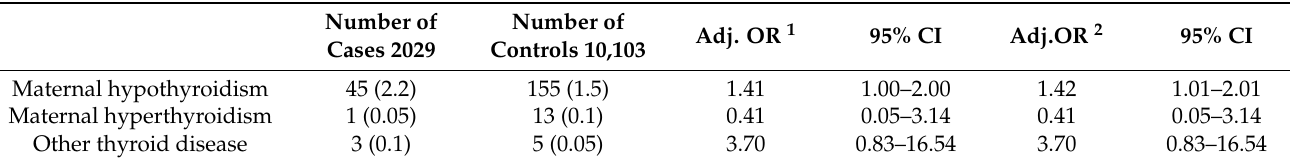
Table 2. Maternal thyroid disease and the risk of childhood cancer in the offspring. Comparison to those of mothers without thyroid disease.